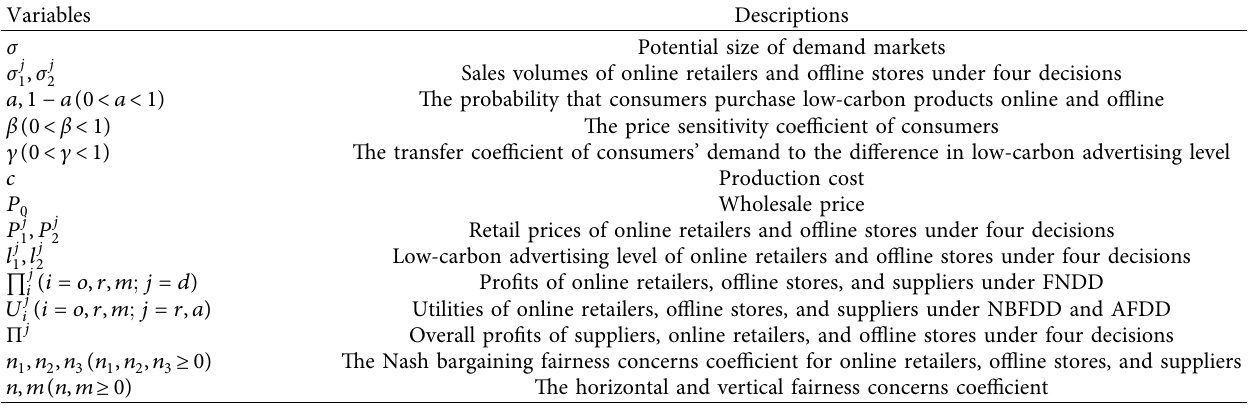
Table 2: Variables and